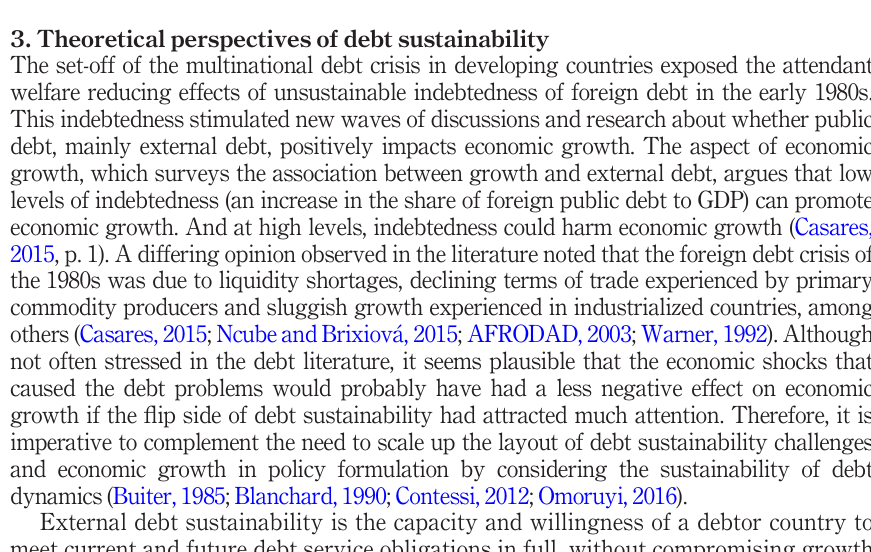
Table 3. Fiscal balances in West Africa,